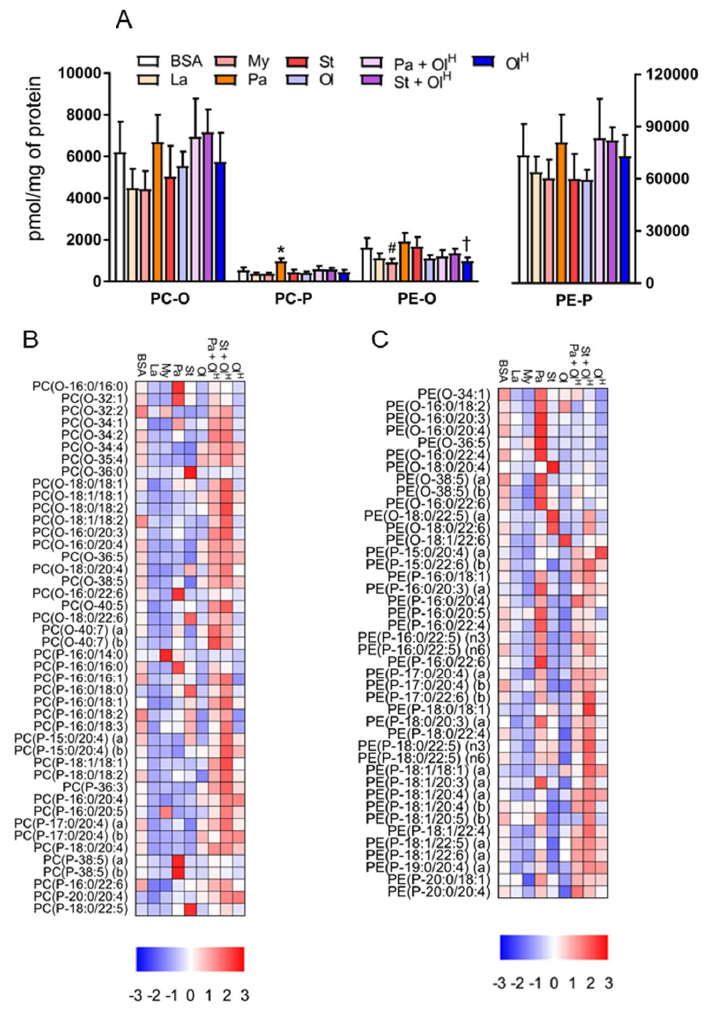
Figure 6. The effects of fatty acids on ether phospholipids. ( A ) Concentrations of total PC-O, PC-P, PE-O and PE-P in BMDM treated with the indicated fatty acids. Data in A are the mean + SD. Symbols represent statistical significance compared with BSA at the following α levels: * p ≤ 0.001; † p ≤ 0.01; # p ≤ 0.05. Heat maps showing the indicated lipid species within PC-O/P ( B ) and PE-O/P ( C ) in BMDM treated with the indicated fatty acids. Data are presented as Z-score by column. Data are from 6 independent